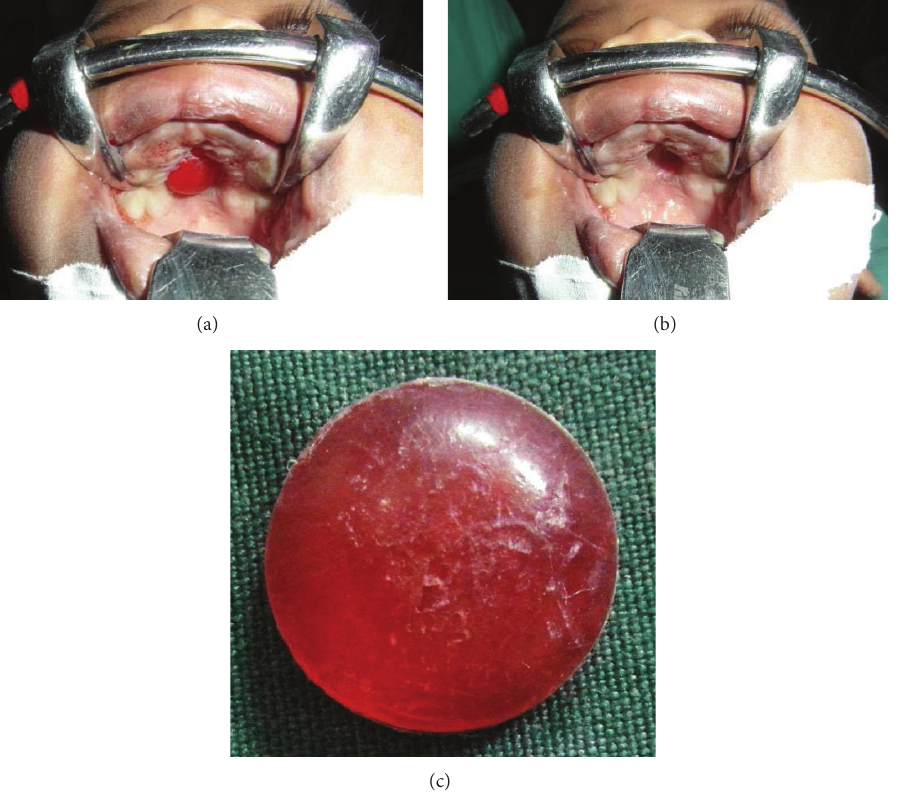
Figure 2: (a) The red foreign body deeply embedded in the hard palate. (b) Successful removal of the foreign body. The indentation on the hand palate is visible. (c) The extracted foreign